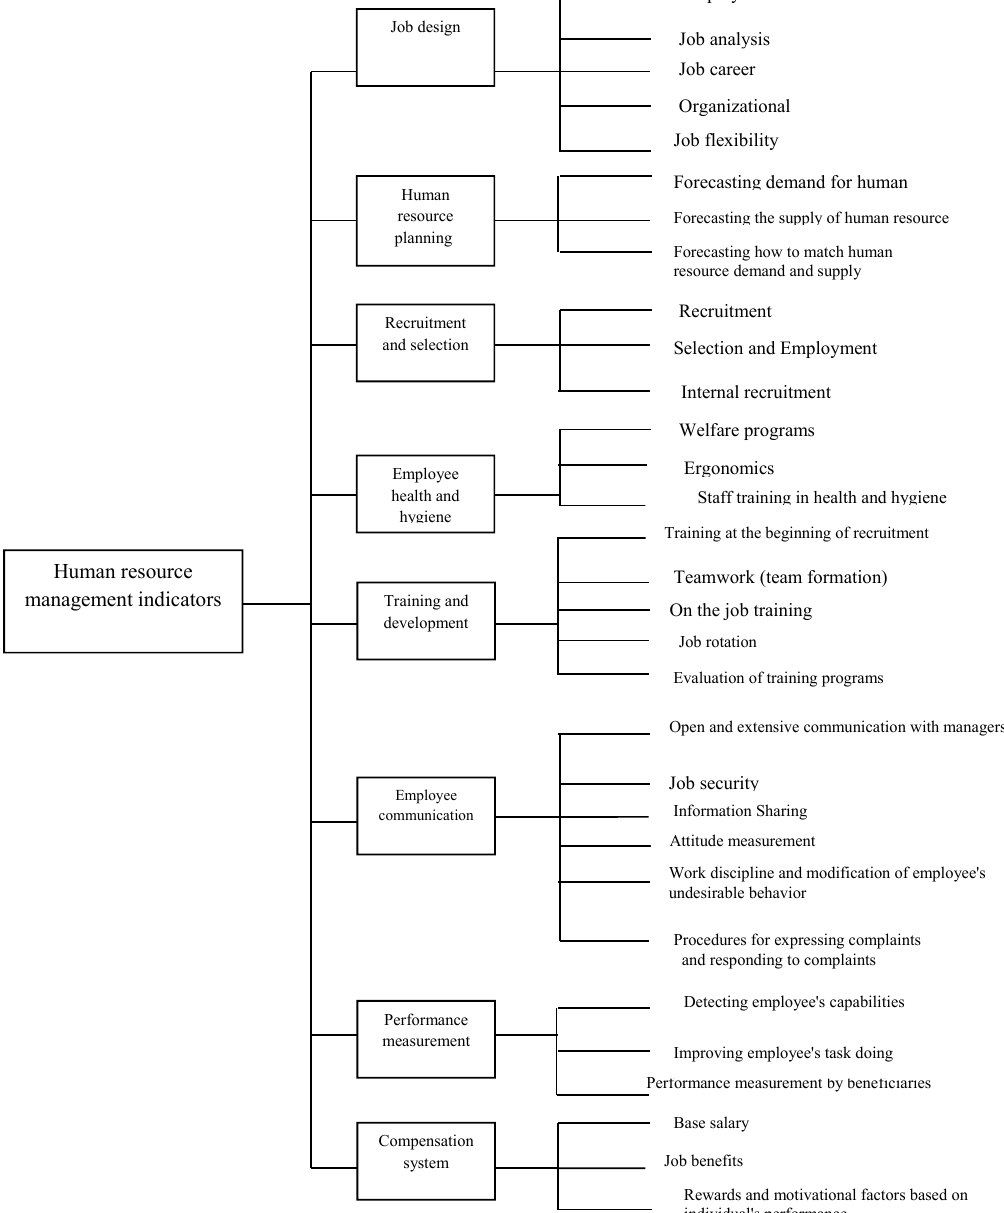
Fig. 1. Hierarchy of indicators and sub-indicators of